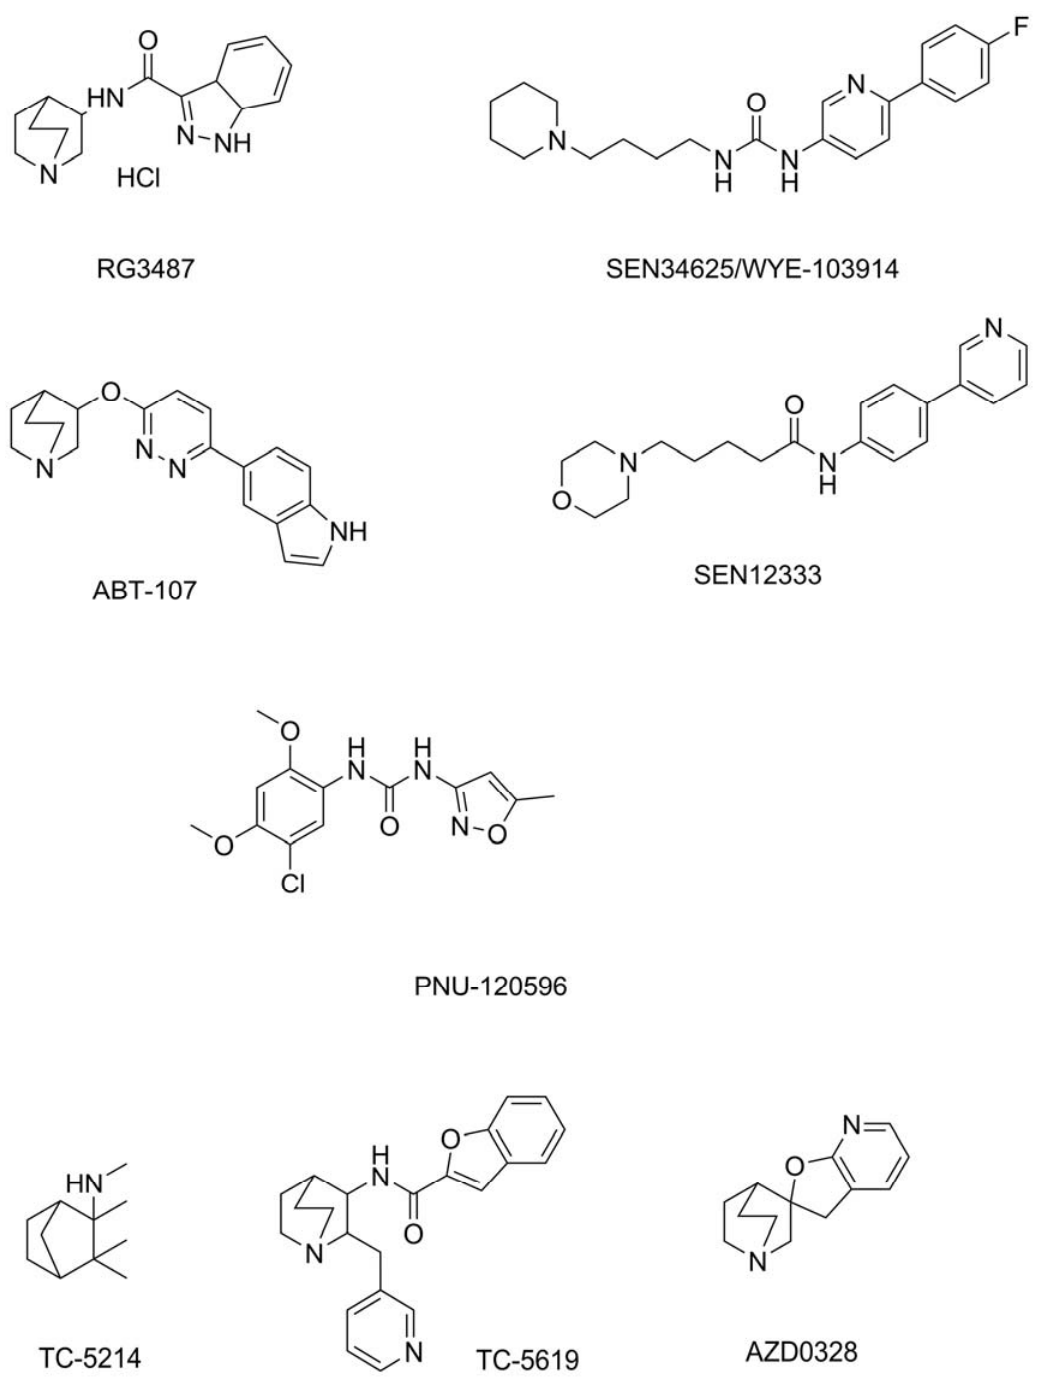
Figure 4. Structures of α 7 nAChR agonists acting in the central nervous